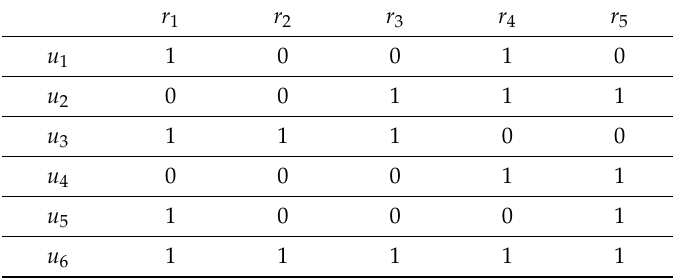
Table 10. Matrix UC .